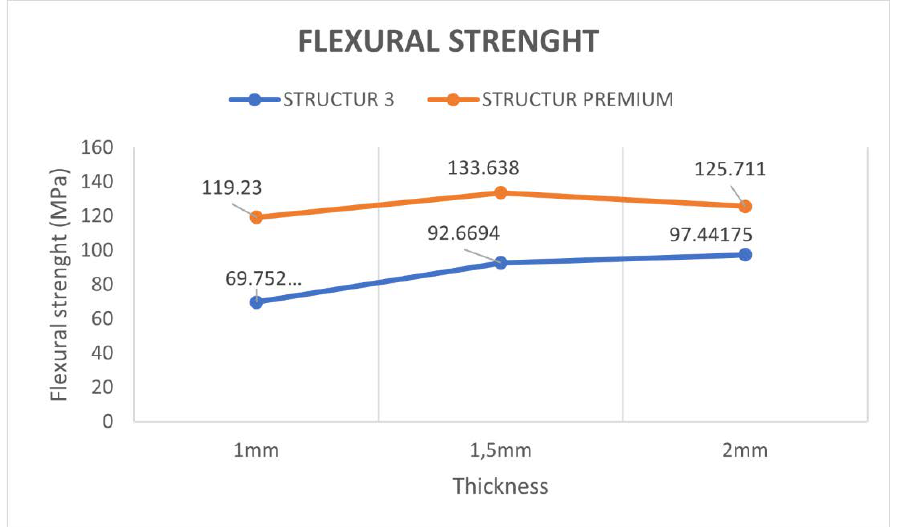
Figure 5. Flexural strength obtained in both materials and comparison between different thickness (median) .